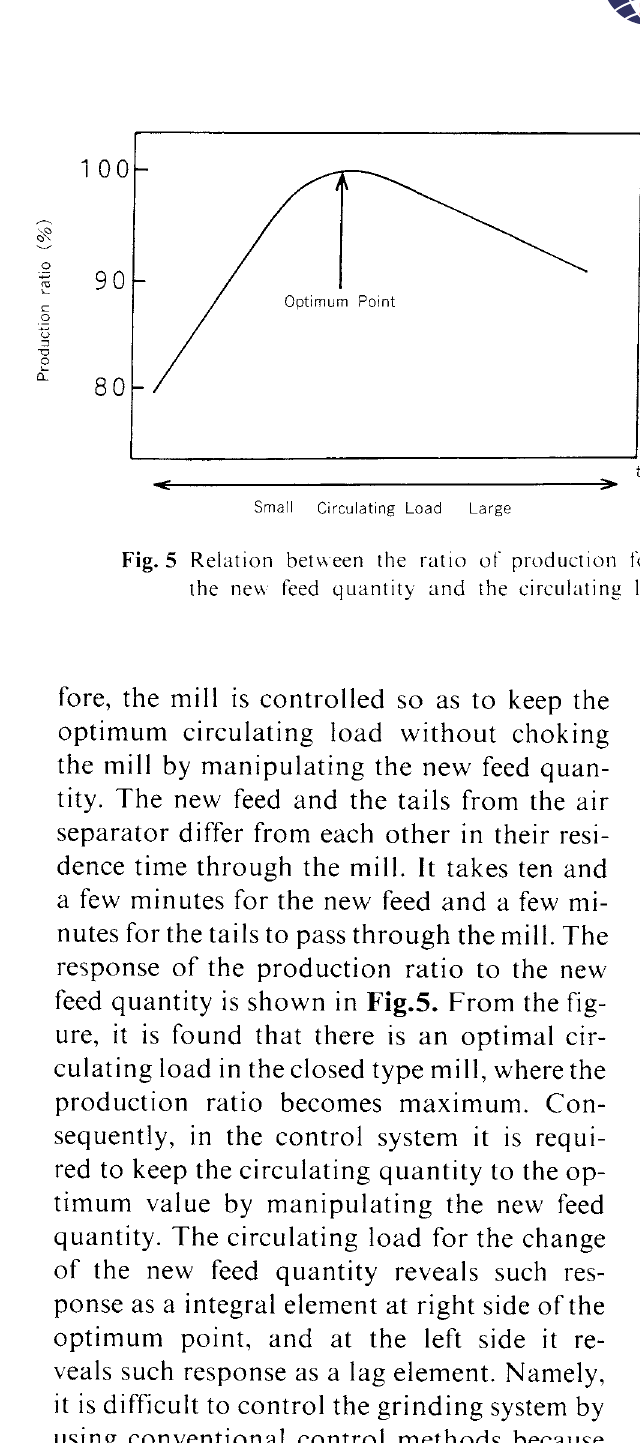
Fig. 4 Schematic diagram of the clo~ed-circuit grinding sy,tem